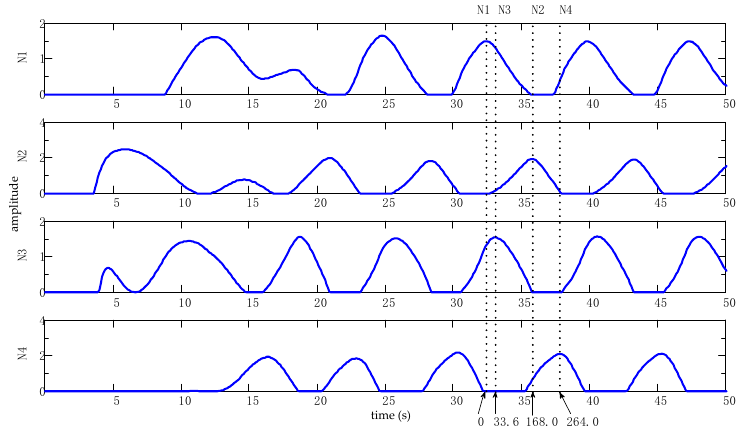
Figure 12. Output signal of the local CPG network.